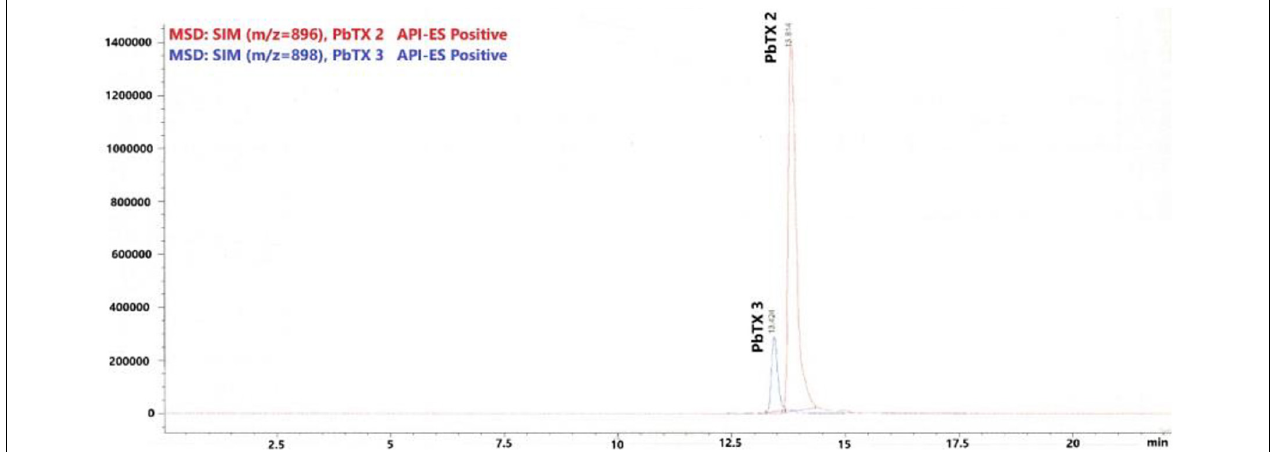
TABLE 3 | Results obtained for brevetoxins screening analysis by LC-MS of dolphin samples collected in Canary Island (Spain). Case no.